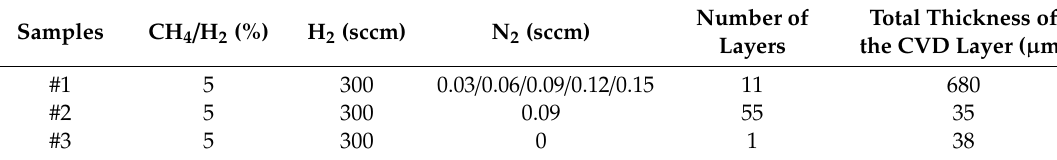
Table 1. Growth parameters for 3 di ff erent